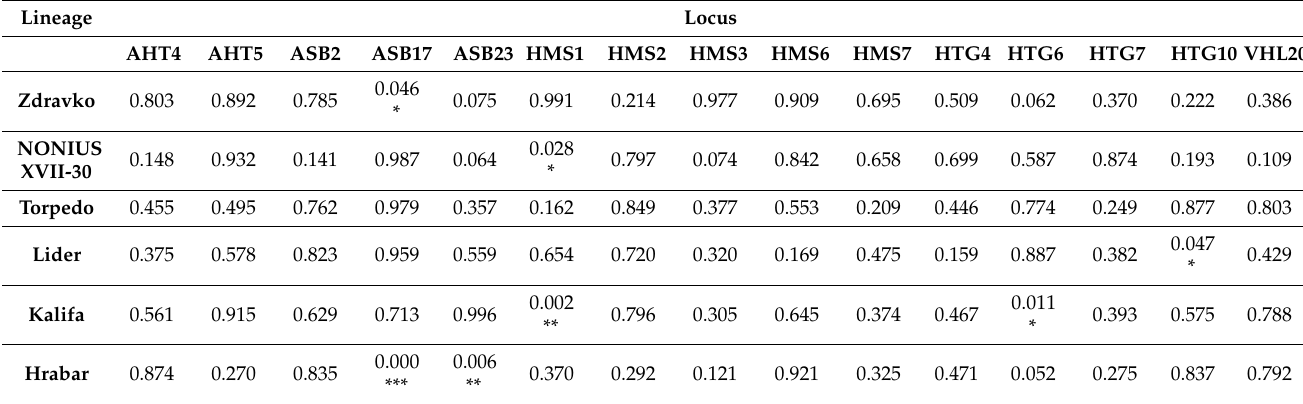
Table 3. Hardy–Weinberg (HWS) equilibrium test for all studied microsatellite loci in the six paternal lineages. Locus